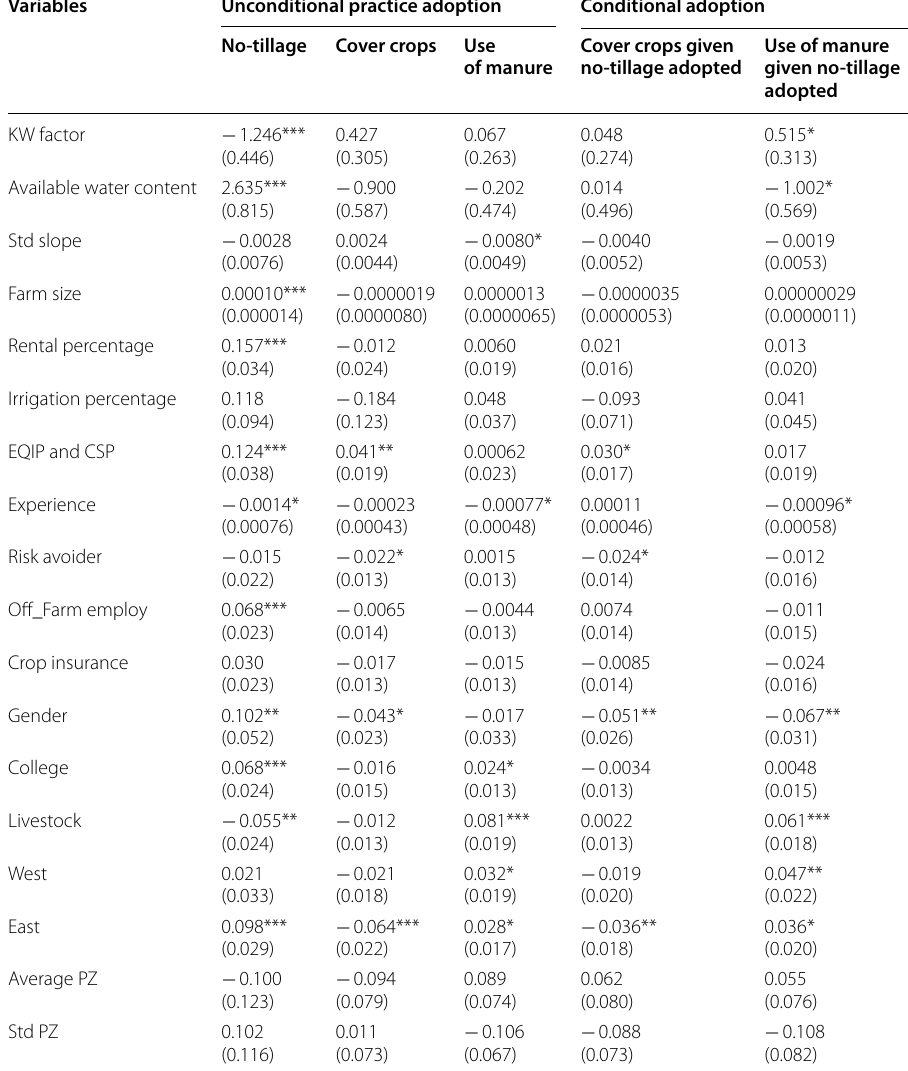
Table 4 Estimated marginal effects for the unconditional and conditional adoption of no-tillage, cover crops and